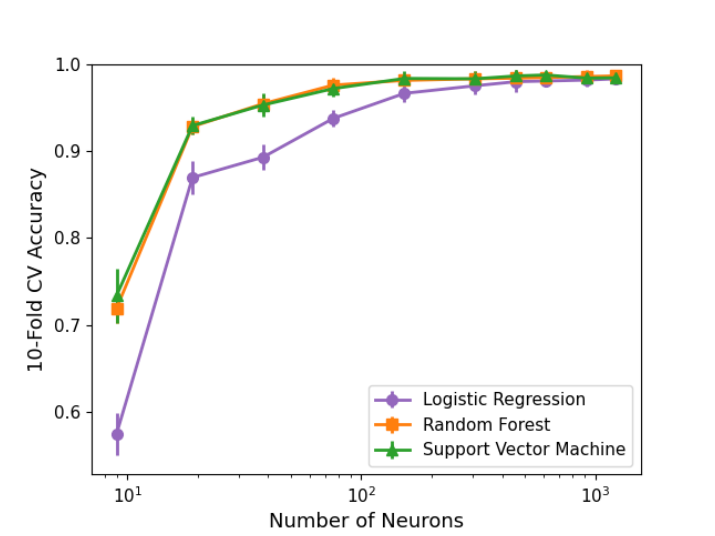
Figure 11. The 10-fold cross-validation accuracy vs. LSM size for all three classifiers. The error bars indicate the standard deviation. It shows the best results irrespective of C inp .